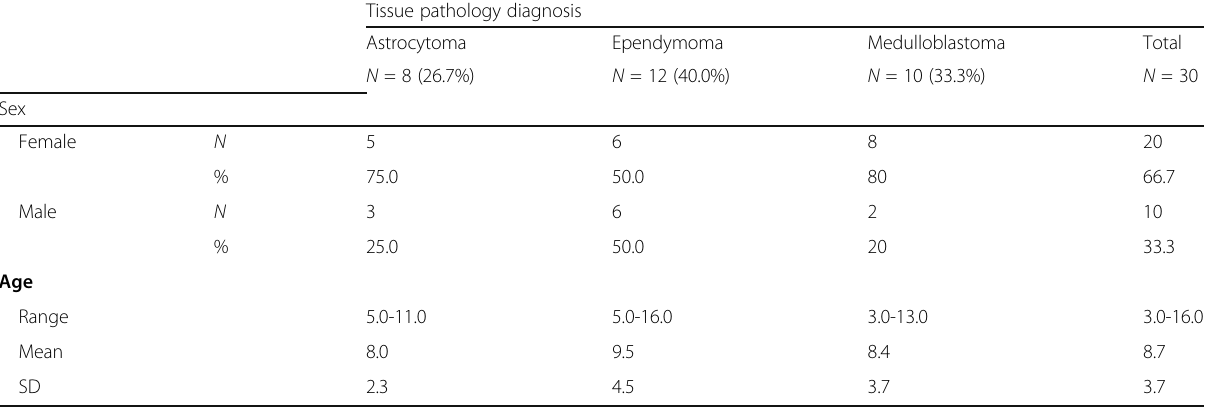
Table 2 Demographic data of the studied cases according to histopathological data ( N = 30) Tissue pathology diagnosis